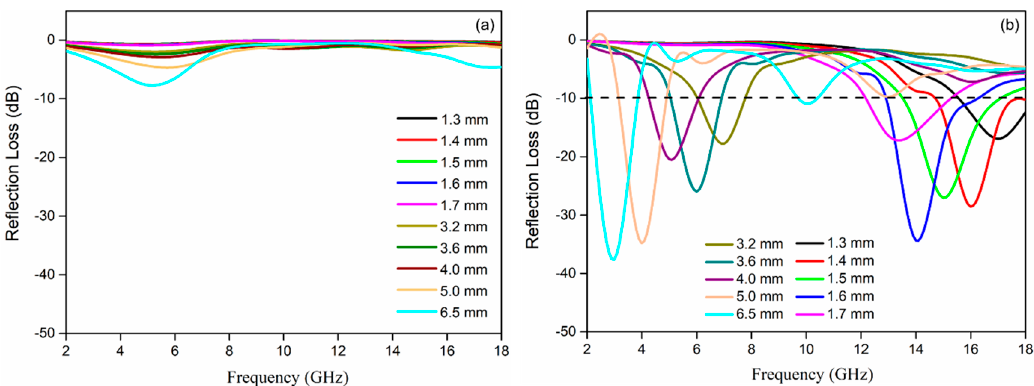
Figure 8. The RL curves of Fe 3 O 4 ( a ) and rGO–Fe 3 O 4 ( b ) with various thickness vs. frequency within the range of 2–18 GHz.